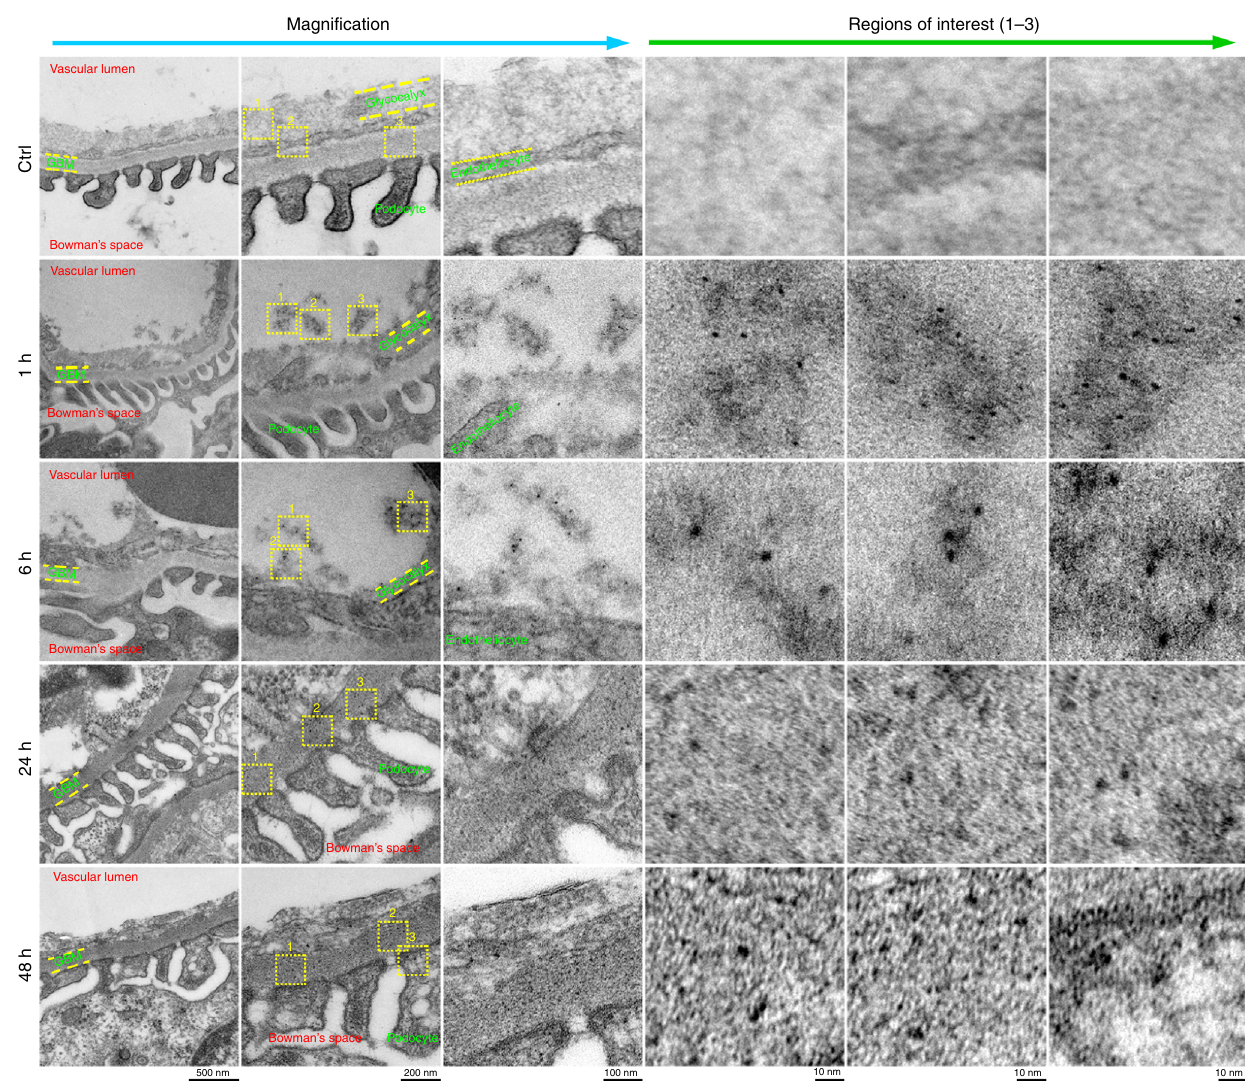
Fig. 3 Glomerulus ultrastructure after cisplatin treatment. No NPs were observed in the region of the glomerular fi ltration membrane, including the glycocalyx, endothelial cells and GBM ( n = 10), in the control mice treated with PBS ( n = 10). In the cisplatin-treated mice, a large number of small Pt NPs (<6 nm) were observed at 1 h, while larger Pt NPs (>6 nm) were observed at 6 h. The Pt NPs (>6 nm) were found in the GBM region at 24 h and 48 h, indicating a slow elimination through the glomerulus. Regions of interest are shown at a higher magni fi